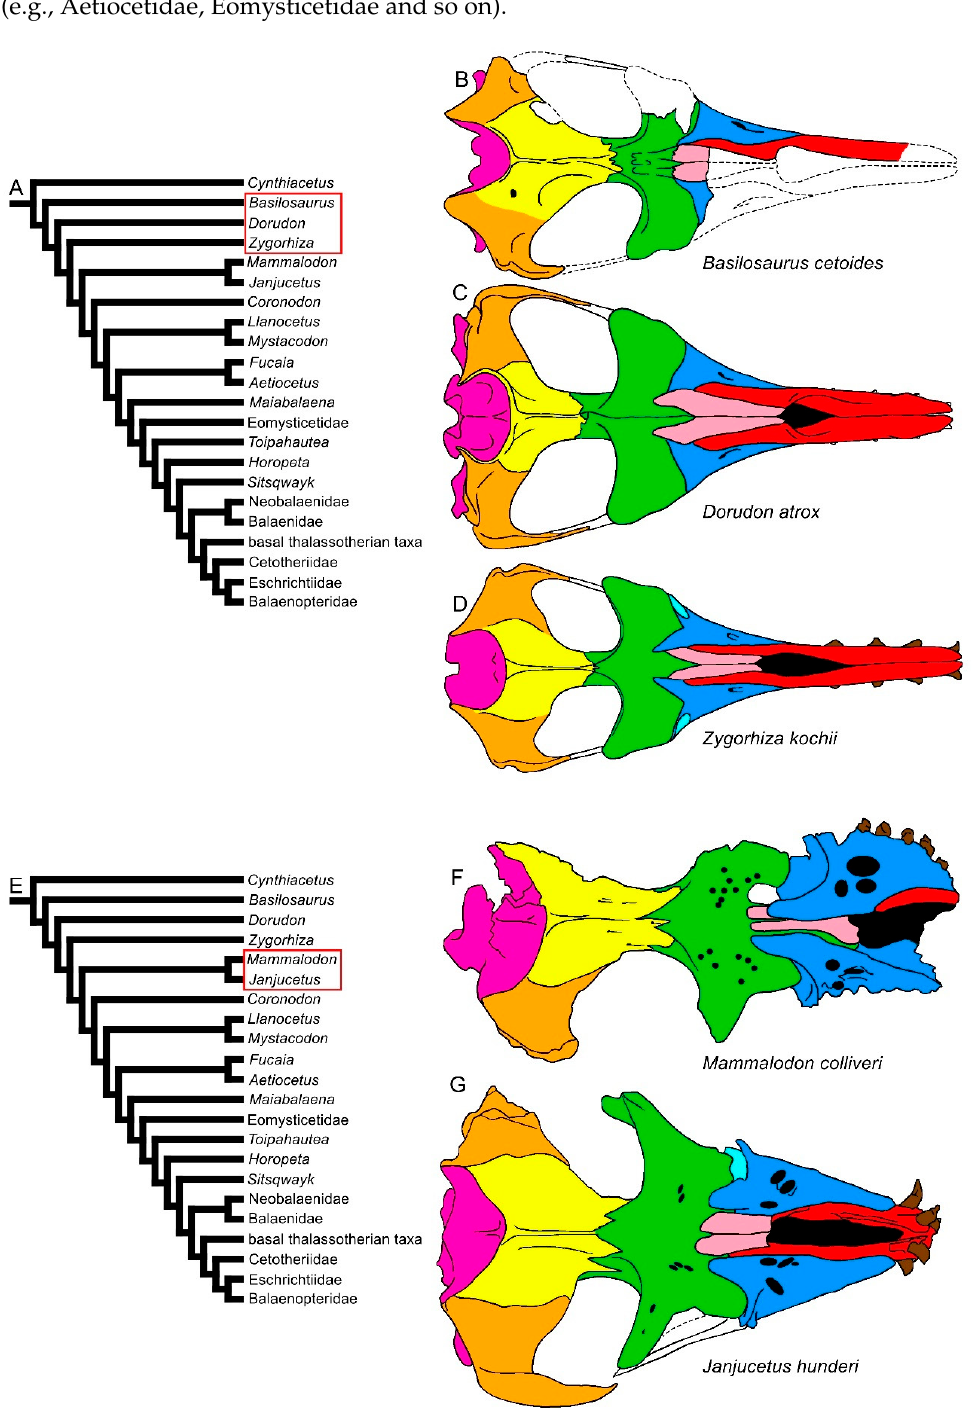
Figure 8. Diversity of the skull in dorsal view in basilosaurine and dorudontine archaeocetes and in mysticetes. ( A ) Phylogenetic relationships among archaeocetes and mysticetes showing the archaeocete branching (red ellipsis). ( B ) Skull of Basilosaurus cetoides . ( C ) Skull of Dorudon atrox . ( D ) Skull of Zygorhiza kochii . ( E ) Phylogenetic relationships among archeocetes and mysticetes showing the ramus leading to Mammalodontidae (red ellipsis). ( F ) Skull of Mammalodon colliveri . ( G ) Skull of Janjucetus hunderi . Not to scale. The skulls are represented as if they shared the same condylobasal